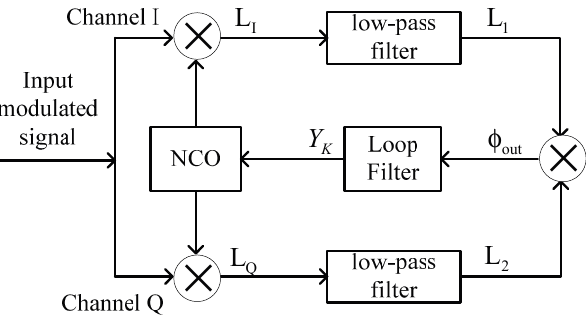
Figure 4. Block diagram of the Costas